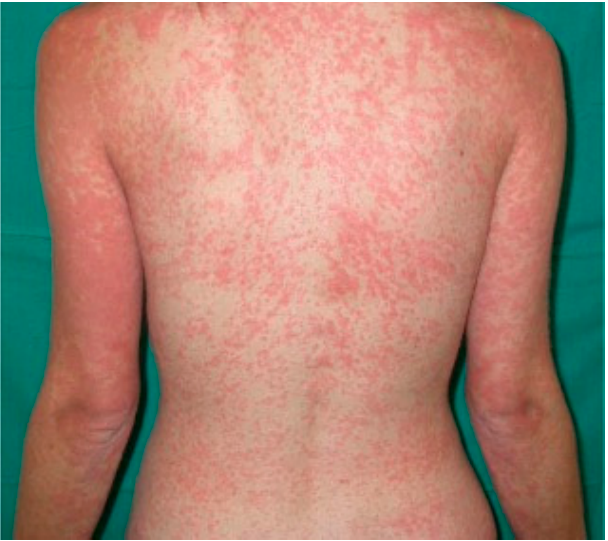
Figure 4. Drug-related erythematous maculopapular eruption on trunk and upper extremities in a young girl.